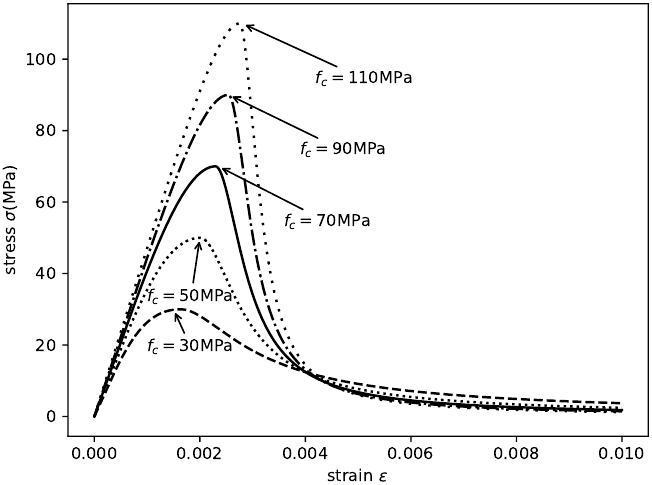
Figure 6. Stress–strain relationships of unconfined